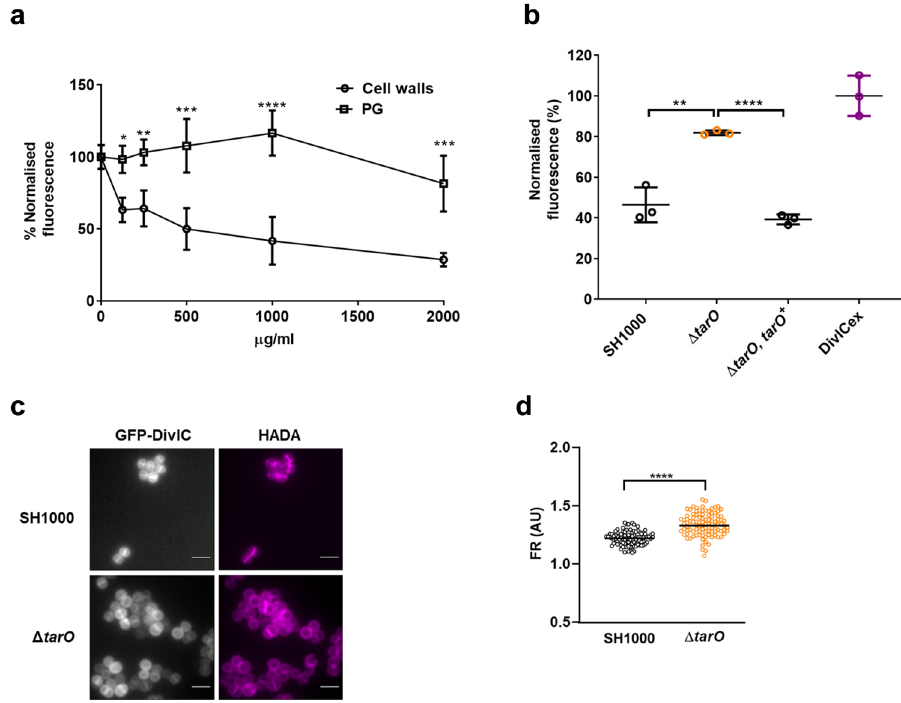
Fig. 6 DivIC interacts with the cell wall in a teichoic acid-dependent manner. a Fluorescence of Cy2-labelled DivIC ex measured after 5 min incubation with puri fi ed cell walls or PG from SH1000. Cy2-labelled DivIC ex fl uorescence was determined in the supernatants after centrifugation to determine the levels of cell wall- or PG-unbound protein. Mean and standard deviations of three independent experiments are shown. P -values were determined by two- tailed t -test corrected for multiple comparison using the Holm- Š ídák method. b Cell walls (0.25 mg/ml) from SH1000, Δ tarO (SJF5289) mutant or complemented Δ tarO (SJF5396) were incubated with Cyt2-labelled DivIC (500 nM) for 5 min and fl uorescence measured in the supernatant after centrifugation. Mean and standard deviations of three independent repeats are shown. P -values were calculated by two-tailed t -test. c Localisation of IPTG- induced GFP-DivIC in SH1000 (SJF5398) and Δ tarO (SJF5395) cells grown to mid exponential phase and incubated with HADA for 30 min to label PG. Scale bars, 2 μ m. d FR between GFP-DivIC fl uorescence signal at the septum versus the cell periphery. Each circle indicates a single cell, lines are mean of an n = 100. P -values were determined by Mann – Whitney U- tests. All images are average intensity projections of z stacks of cells with incomplete septa. Data is representative of two independent experiments. (* P < 0.05, ** P < 0.01, *** P < 0.005, **** P <